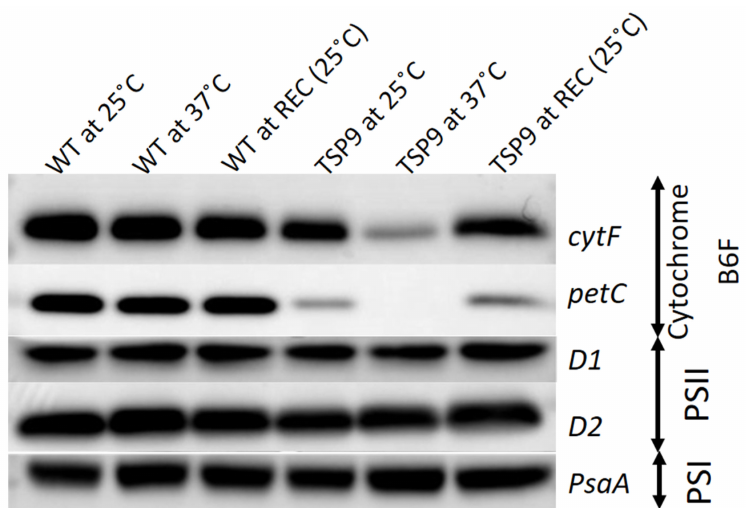
Figure 3. Immunoblots of isolated thylakoid membranes from the wild type (WT) and TSP9 strains grown at three temperature conditions (indicated at the top). The labels to the right of the panels indicate the various subunits (left column) and the complex to which they belong: cytochrome b6f, photosystem I (PSI), and photosystem II